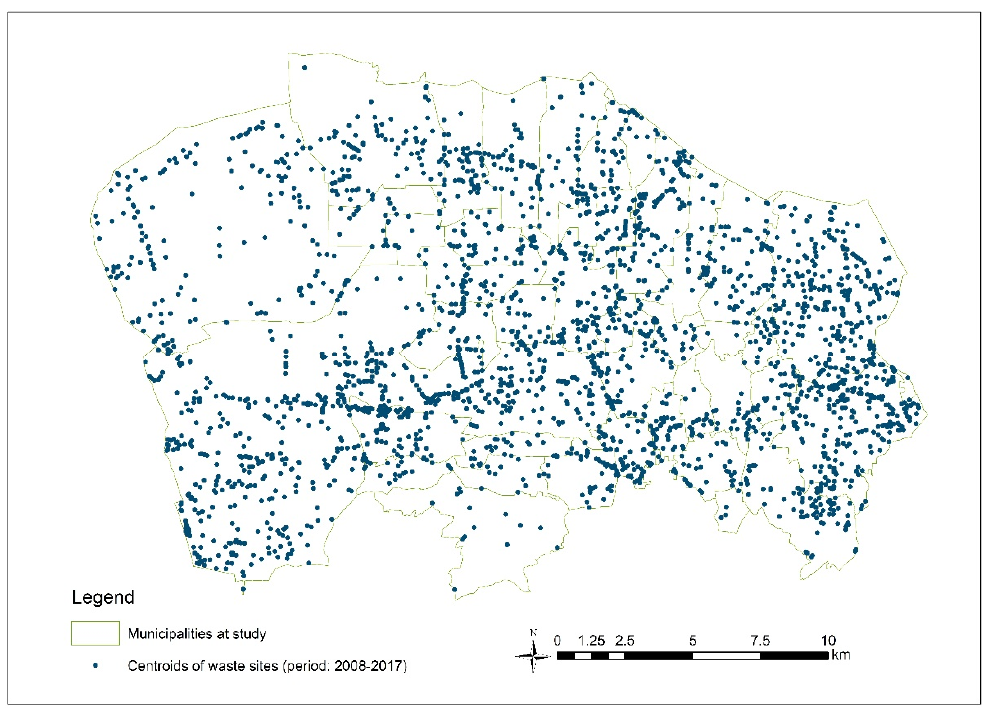
Figure 2. The waste sites in the study area. Period: 2008–2017.